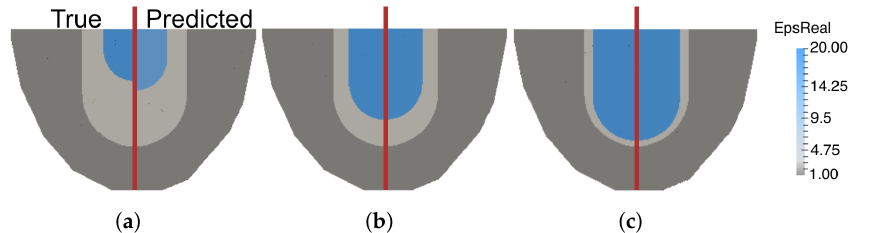
Figure 6. True values (left) versus neural network predictions (right) for the fibroglandular region for the T1 test examples for the ( a ) small fibroglandular case, ( b ) medium fibroglandular case, and ( c ) large fibroglandular case. The associated differences in the predicted complex-valued permittivity are provided in Table